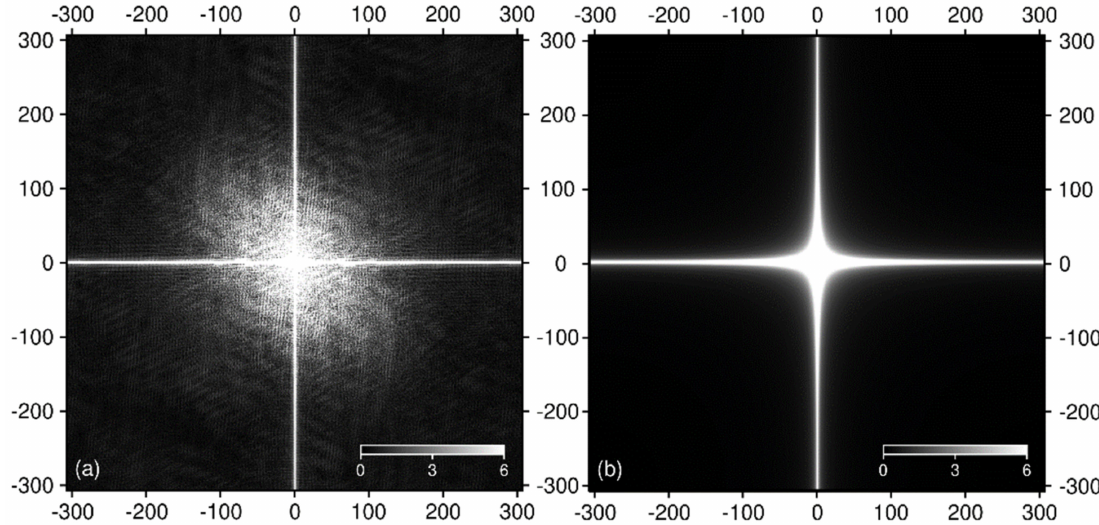
Figure 16. The frequency spectrum of the second windowed area marked in Figure 11 from the obtained DSM ( a ) and SRTM DEM ( b